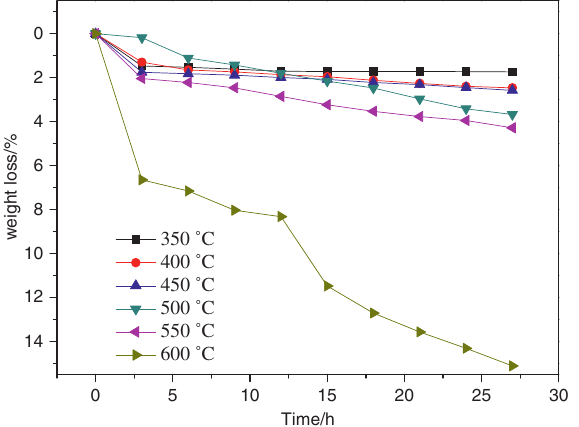
Figure 2: Weight loss vs time of purified sodium nitrate molten salt at different temperatures.